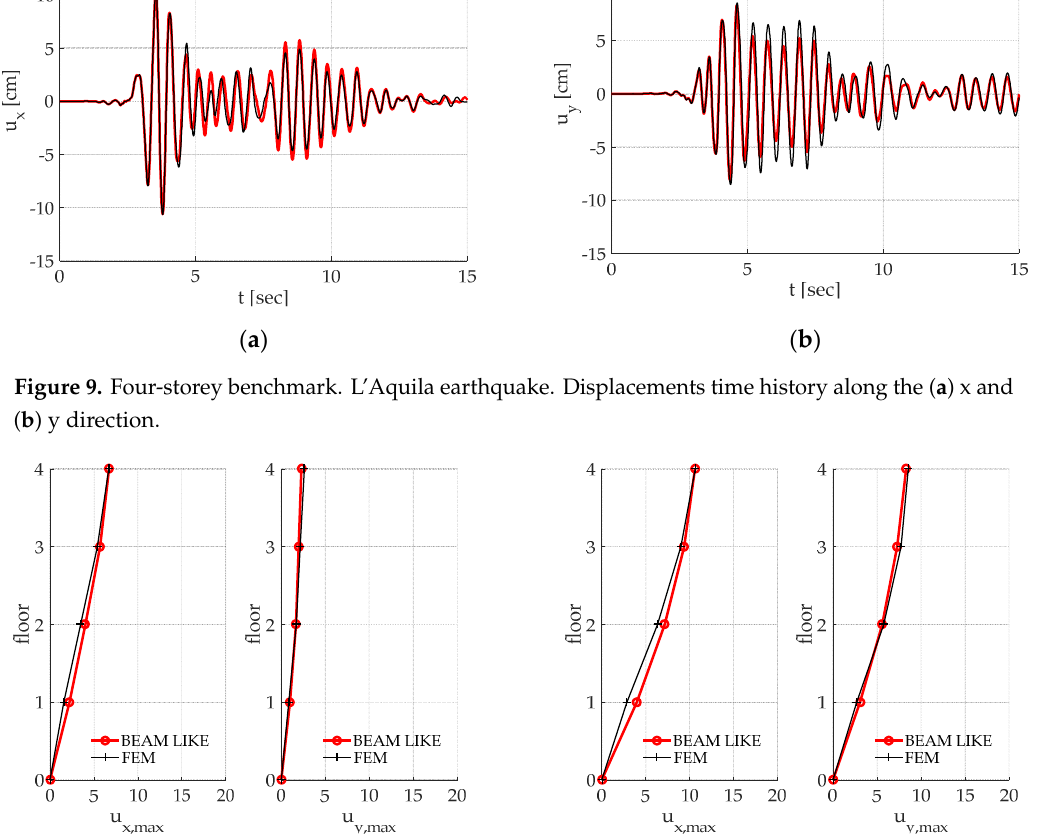
Figure 10. Four-storey benchmark. Maxima floor displacements in the ( a ) Santa Venerina and ( b ) L’Aquila earthquakes.